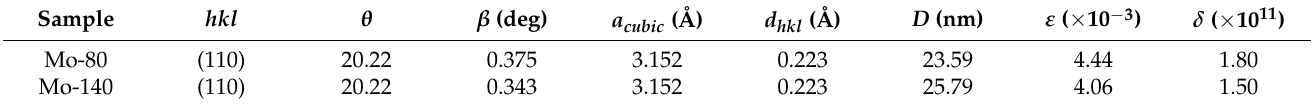
Table 3. Calculated structural parameters of sputtered Mo thin